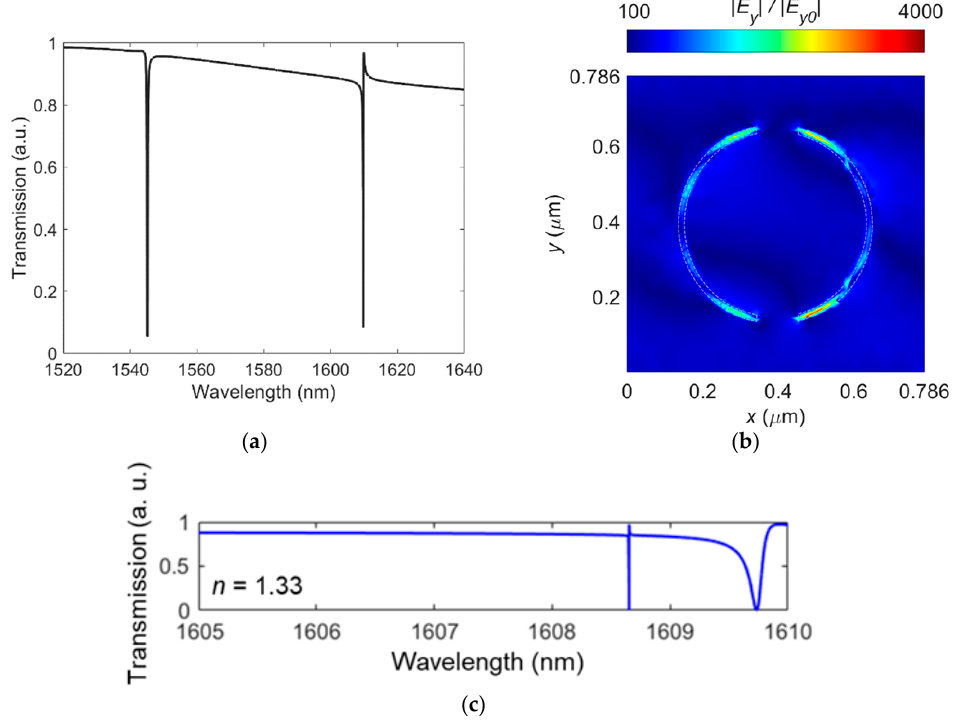
Figure 2. ( a ) Transmission spectrum of the symmetric MS ( t x = 0). ( b ) Electric field (E y ) distribution relevant to the quasi-BIC resonant mode at the top of the asymmetric MS ( t x = 10 nm) irradiated in the z -direction by a y -polarized plane wave. ( c ) Transmission spectrum of the asymmetric MS ( t x = 10 nm).